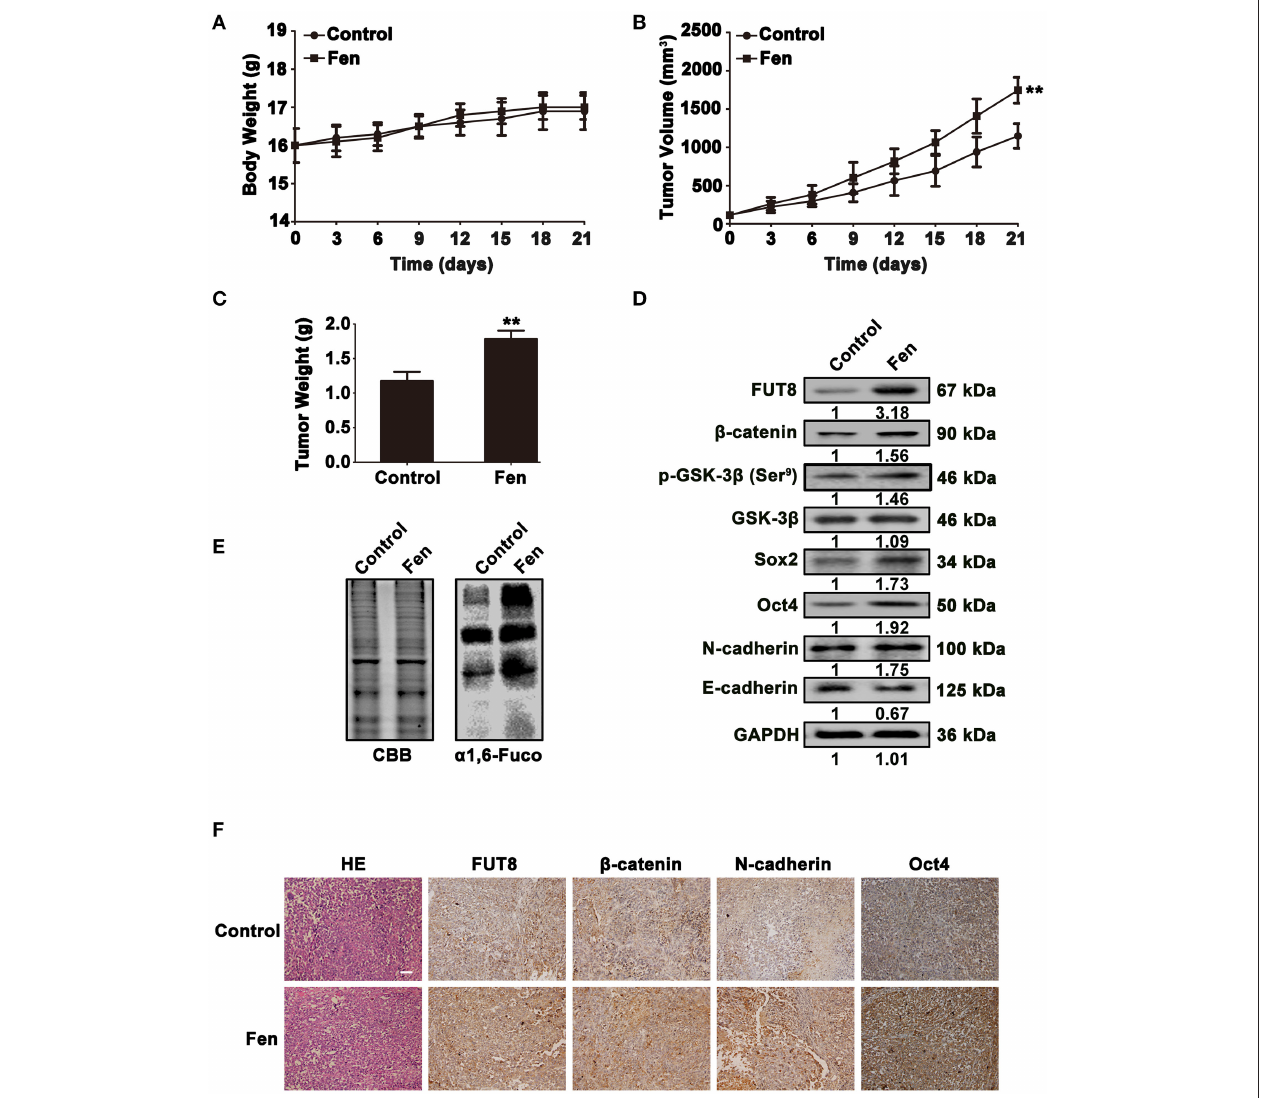
FIGURE 6 | Fentanyl promotes tumor progression in tumor Xenograft. (A–C) Histograms of body weight, tumor volume and tumor weight. (D,E) Western blot and Lectin blot analysis for FUT8, α 1, 6-fucosylation, β -catenin, GSK-3 β , p-GSK-3 β (Ser 9 ), Oct4, Sox2, N-cadherin and E-cadherin expression levels in xenograft tumor tissues. (F) H&E and immunohistochemical staining of FUT8, β -catenin, N-cadherin and Oct4. (Scale bars = 100 µ m; Magnification, 200 × ). Data are represented as mean ± SD ( n = 3). Statistical significant difference (** P < 0.01).